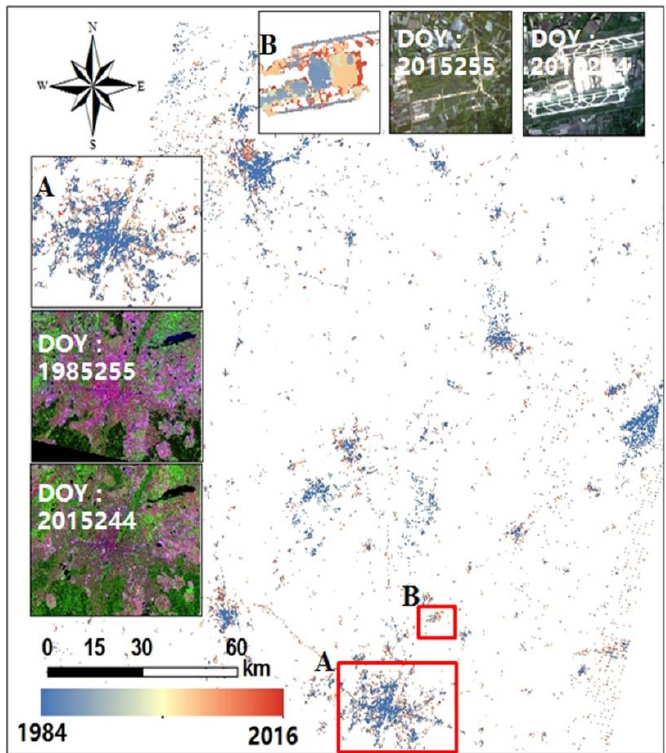
Figure 11. Urban expansion during 1984–2016 in Munich, with insets providing magnified views of ( A ) Munich city center and ( B ) Munich airport. TM images corresponding to the beginning and end of the analysis period are also shown.